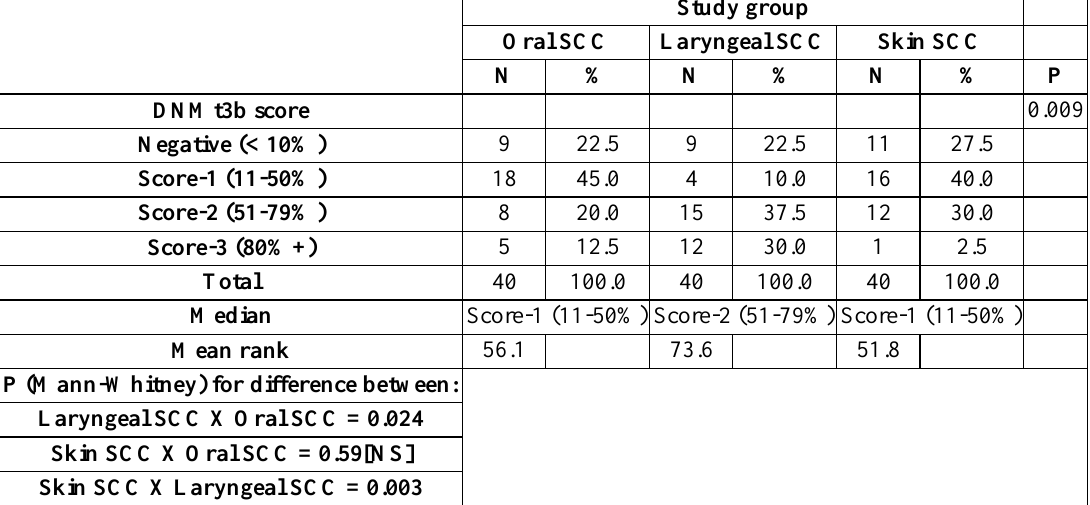
Table 3: The difference in median score category of DNMT3B between the 3 study